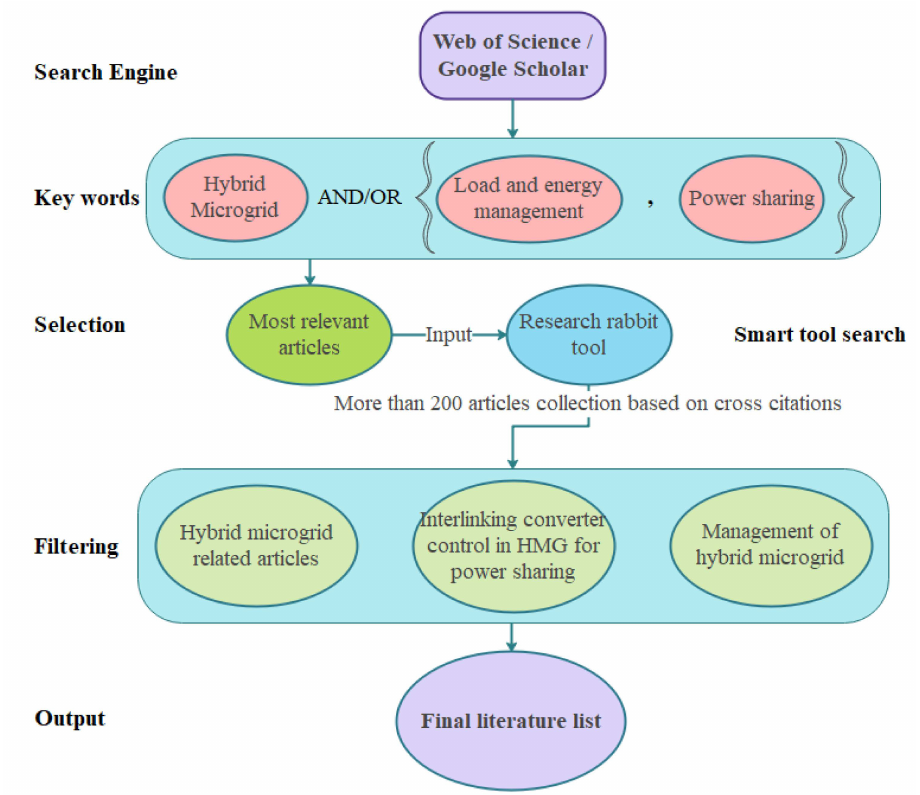
Figure 1. Methodology of data collection for this review.